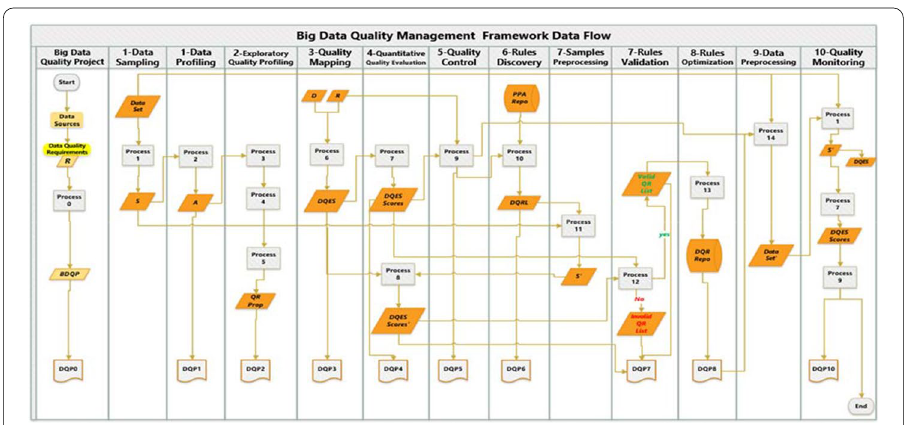
Fig. 12 Big data quality management framework data